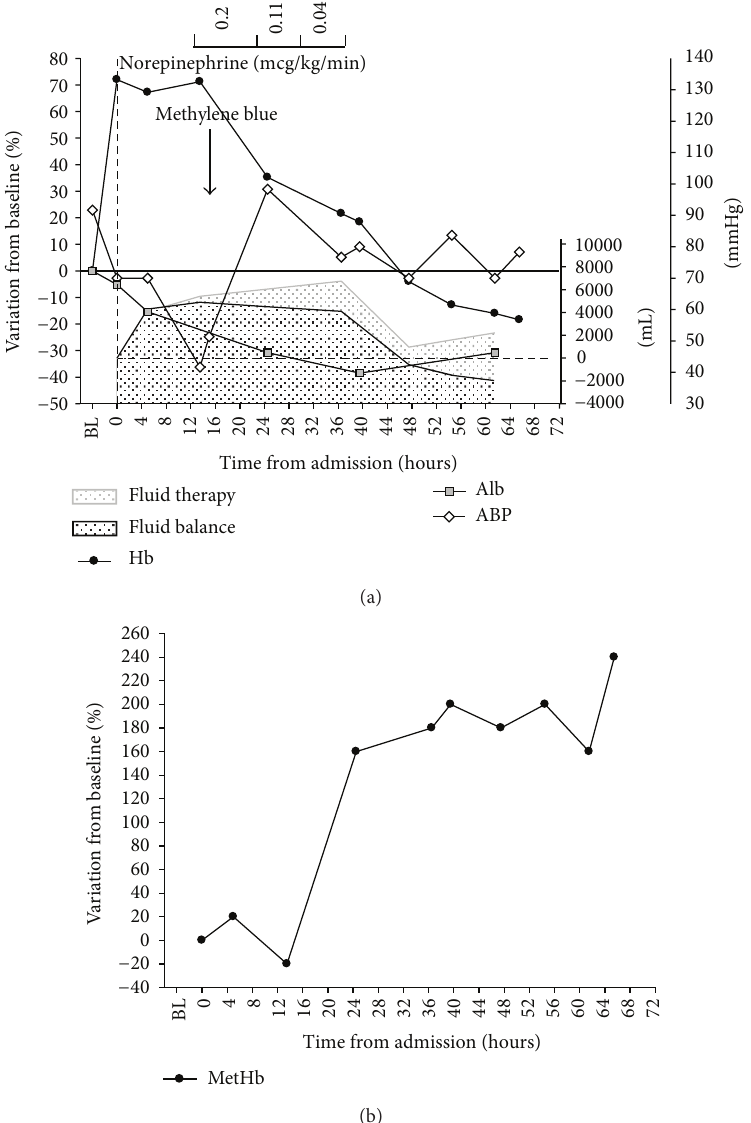
Figure 1: (a) Time course of blood pressure, haemoglobin, and albumin levels during the acute episode and effects of therapeutic inter- ventions. (b) Time course of methemoglobin during the acute episode. BL: baseline (3 months before the acute episode), Hb: haemoglobin (% variation form baseline), Alb: albumin (% variation form baseline), ABP: mean arterial blood pressure (absolute value), and MetHb: methaemoglobin (% variation form